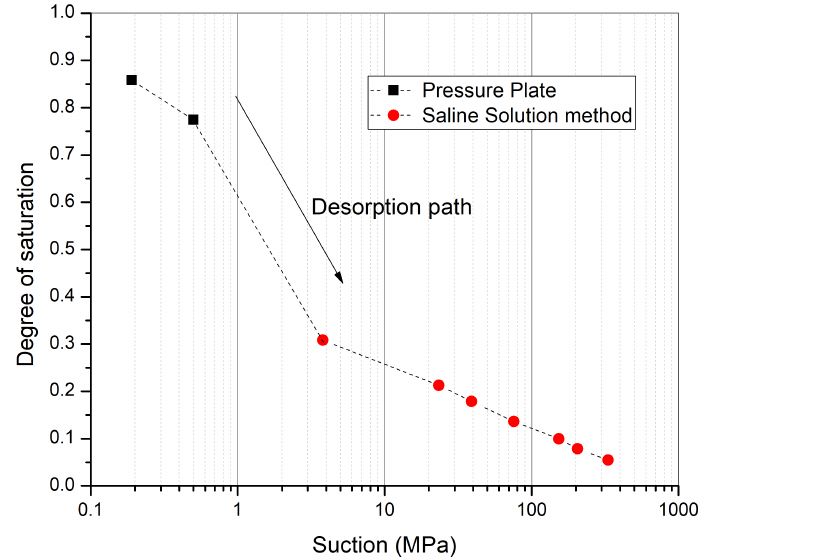
Figure 2. Soil water retention curve using the results of the pressure plate test and saline solution